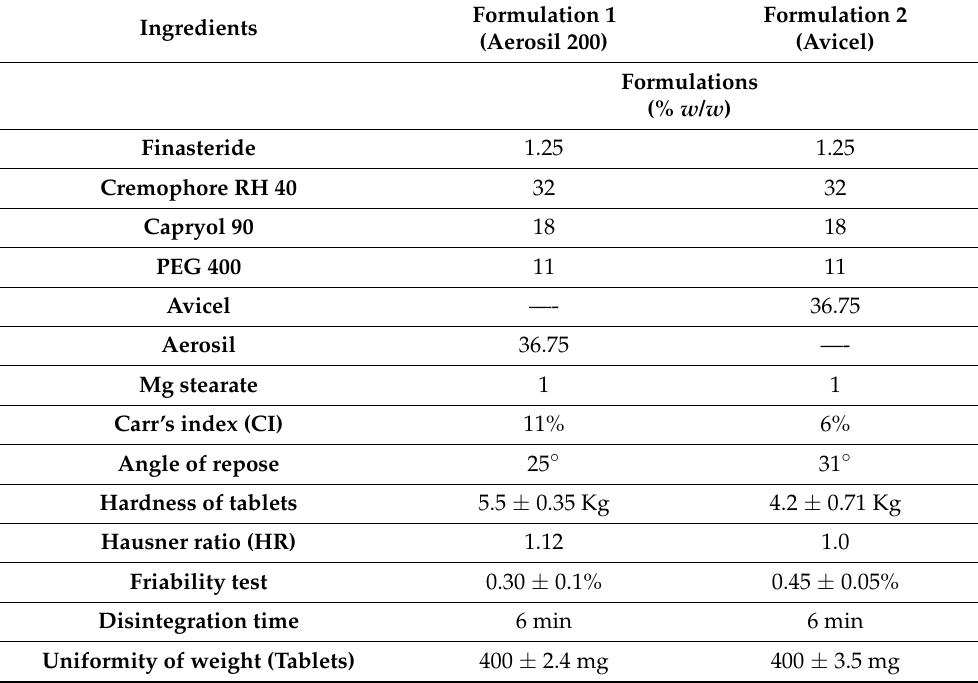
Table 3. Results of physical characterization tests for S-SNEDDS powders and S-SNEDDS